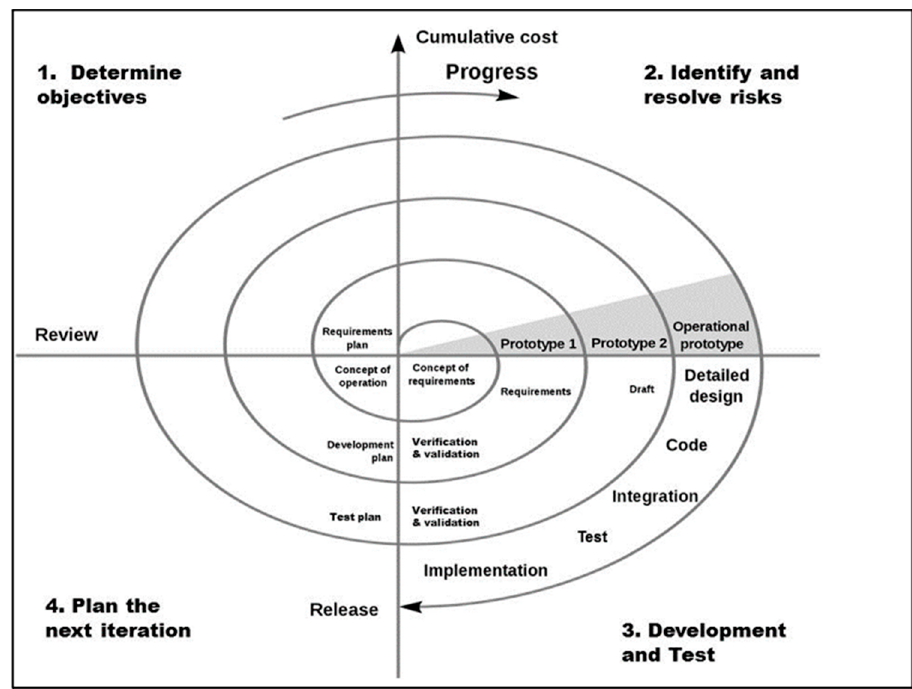
Figure 2. Spiral model of system development is intended to reduce risks that system will not meet user needs (after [10]).